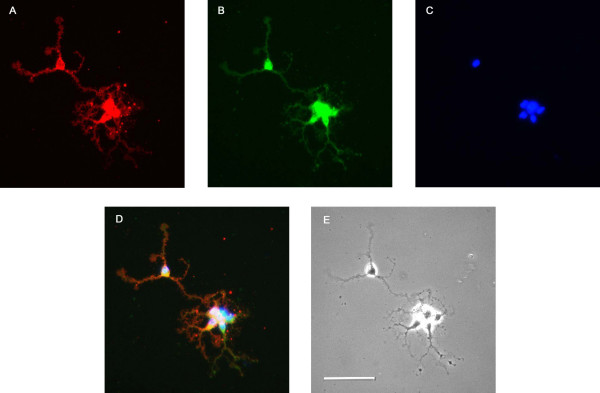
Identification of cultured adult rat RGCs. Cultured cells were co-labeled with anti-Thy-1 antibody (A), anti-NF-L antibody (B), and DAPI (C). (D) A digitally merged image simultaneously represents all three fluorescent labels. (E) The corresponding phase-contrast image. The cells were cultured for 3 days under control conditions. Scale bar = 50 μm.